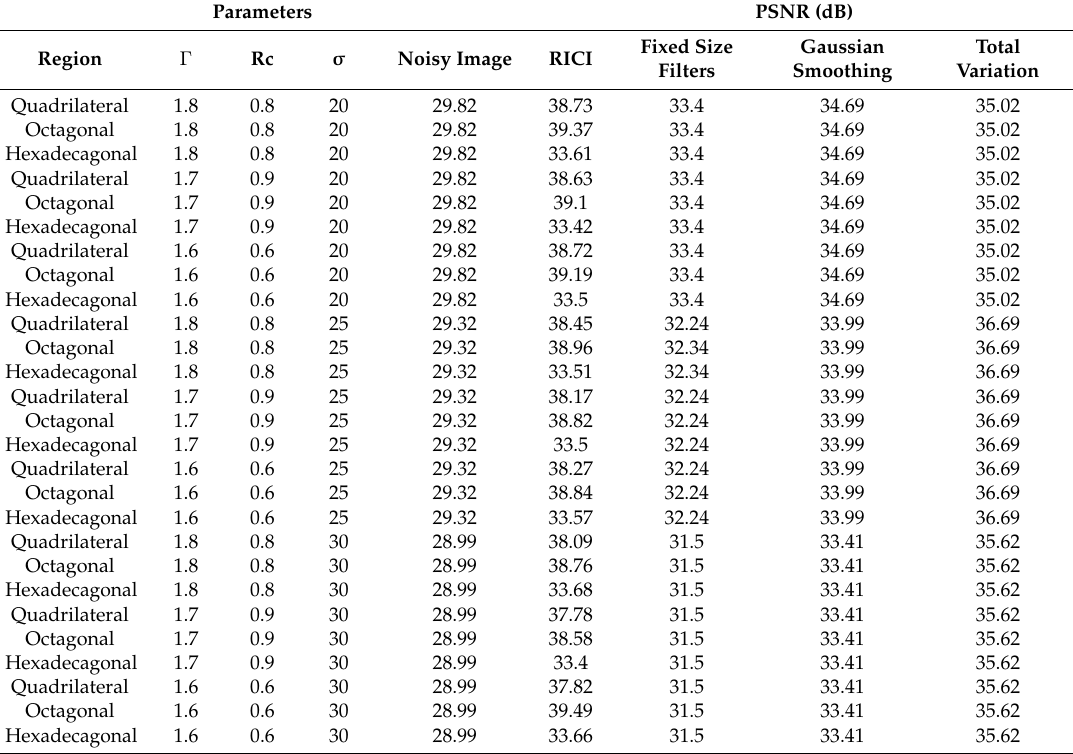
Table 1. PSNRs for shoulder X-ray images denoised using the proposed 2D LPA-RICI method and competitive